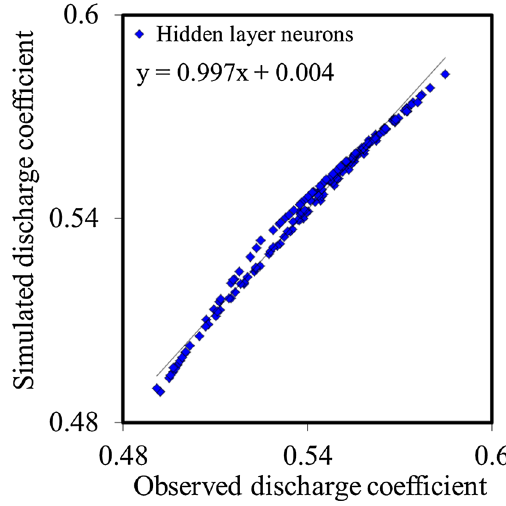
Fig. 6 Scatter plot for RELM with HLNN =